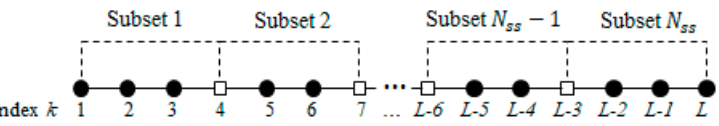
Figure 2. One sample overlapped subsets in the GNSE (𝐾 = 4) .